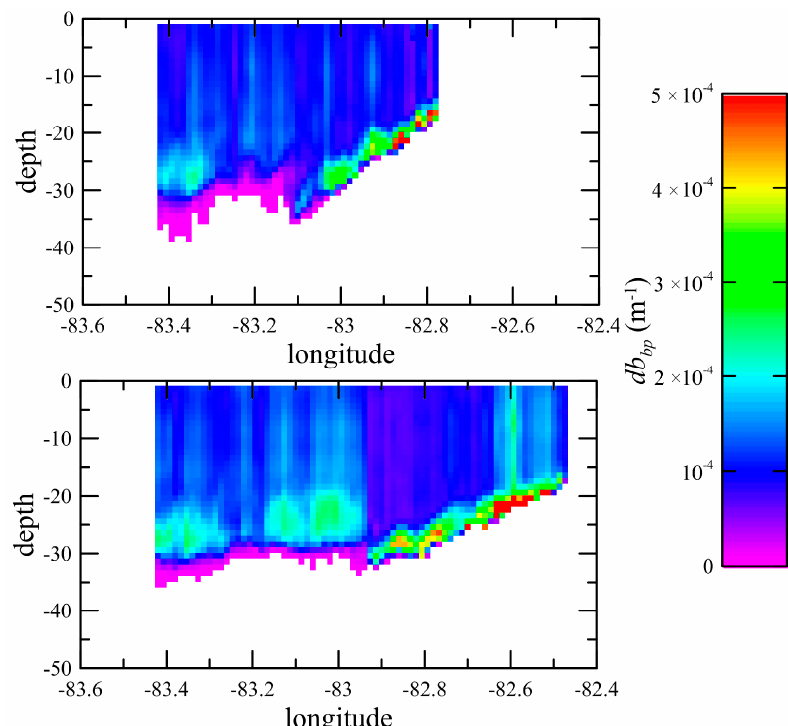
Figure 6. Product of depolarization, d , and particulate backscatter coefficient b bp as a function of depth and longitude for the cross-polarized lidar return for the northern (top) and southern (bottom) transects. Because the lidar flights were more concentrated towards the earlier portion of the glider mission, the displayed lidar data were averaged over the first three flights for the northern transect and the second and third flights for the southern transect. They are binned into 0.01° latitude by 1 m depth bins.